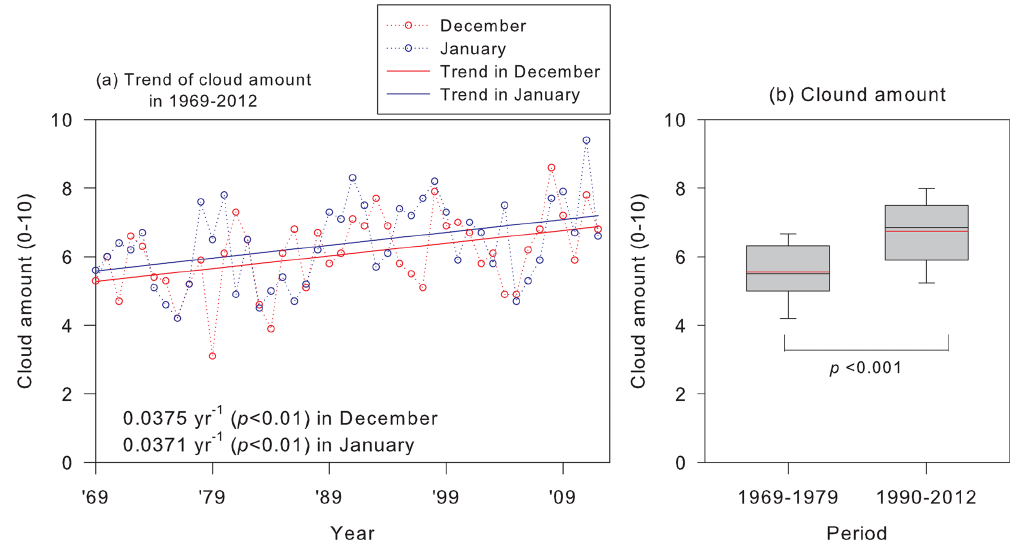
Figure 11. (a) Trend of monthly mean cloud amount in 1969–2012 and (b) comparison of cloud amounts in December–January before and after appearance of the Antarctic ozone hole at Syowa Station, Antarctica. p denotes the p value of the ANOVA variance test. Degrees of freedom for the ANOVA variance test were 66. Because of the extended period of the ozone hole in 1980–1989, cloud amount data in the period were excluded from Fig. 9b. Box plots show values of 90%, 75%, 50% (median), 25%, and 10% denoted, respectively, by the top bar, top box line, black middle box line, bottom box line, and bottom bar. Red lines show mean values. Cloud amounts were observed based on visual observations by the Japan Meteorological Agency (http://www.jma.go.jp/jma/indexe.html, last access: 6 August 2021).